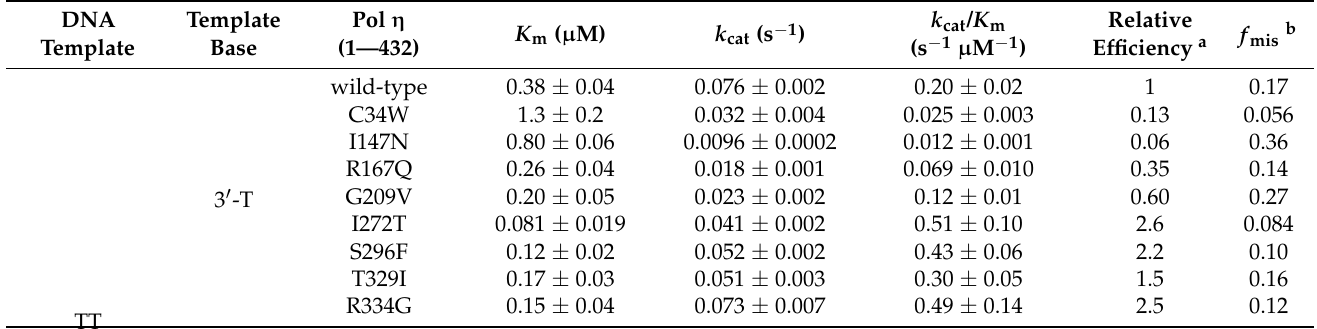
Figure 2. Extension of primers opposite a TT or cis - syn cyclobutane thymine dimer (CTD) by human pol η (1—432) wild-type and variants. ( A ) Analysis of human pol η (1—432) wild-type and variant proteins by SDS-PAGE. Purified recombinant pol η (1—432) proteins (400 ng each) were separated on a 10% SDS-PAGE gel ( w / v ) and visualized by Coomassie brilliant blue staining. Protein size markers are shown on the left. ( B ) The P 32 -labeled 17-mer/25-mer, containing a TT or CTD, was incubated with all four dNTPs (50 μ M each) and the indicated concentrations of pol η , for 15 min. The reaction products were analyzed by denaturing PAGE and phosphor imaging. Upper panel: extension opposite TT. Lower panel: extension opposite CTD. Table 2. Steady-state kinetic parameters for dATP incorporation opposite the 3 ′ - and 5 ′ -T of a TT or CTD by human wild-type pol η (1—432) and variants.